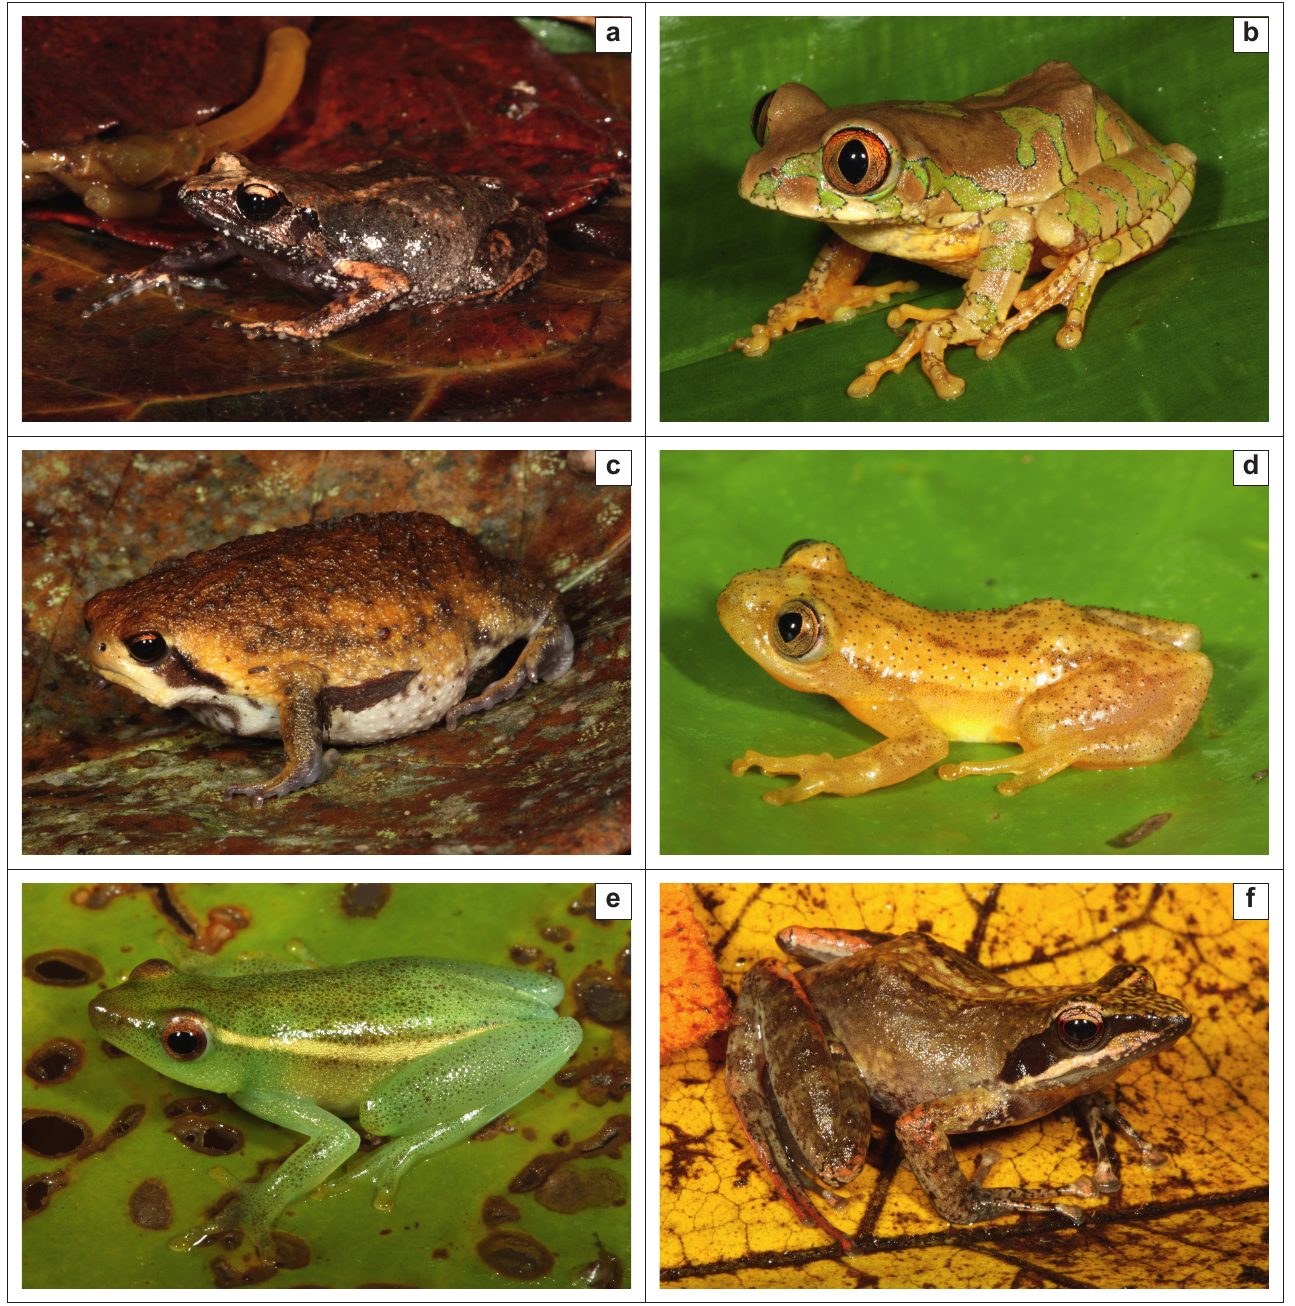
FIGURE 3: Amphibian species of special or conservation concern recorded in protected areas along the Wild Coast, including (a) Arthroleptis wahlbergii (Hluleka NR), (b) Leptopelis natalensis (Silaka NR), (c) Breviceps cf. bagginsi (Silaka NR), (d) Afrixalus spinifrons (Hluleka NR), (e) Hyperolius poweri (Mkambati NR) and (f) Natalobatrachus bonebergi (Manubi